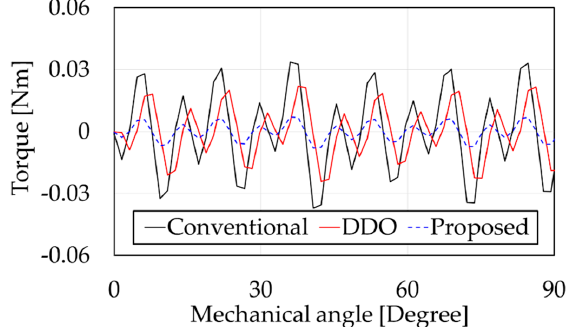
Figure 11. Experimental setup.